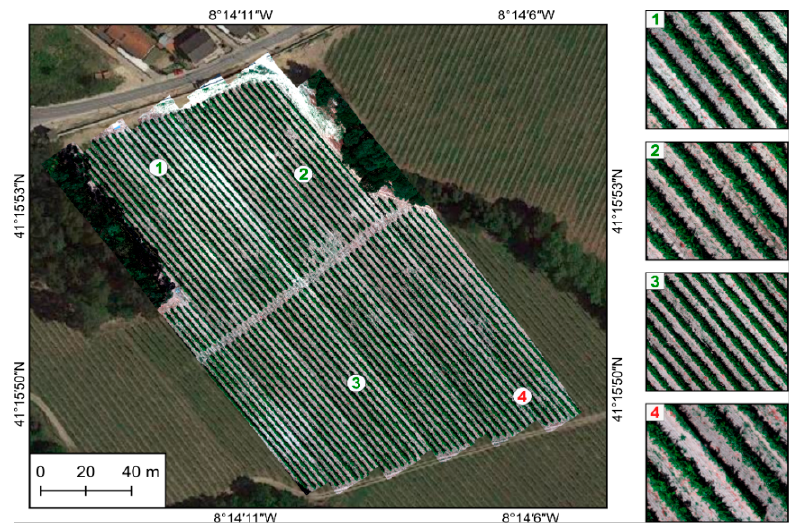
Figure 19. Lousada area: overview of the final hyperspectral mosaic and close-ups to show the good alignment achieved by continuous linear features ( 1 – 3 ). Few misalignments are still present, but only at the edge of the mosaic ( 4 ).